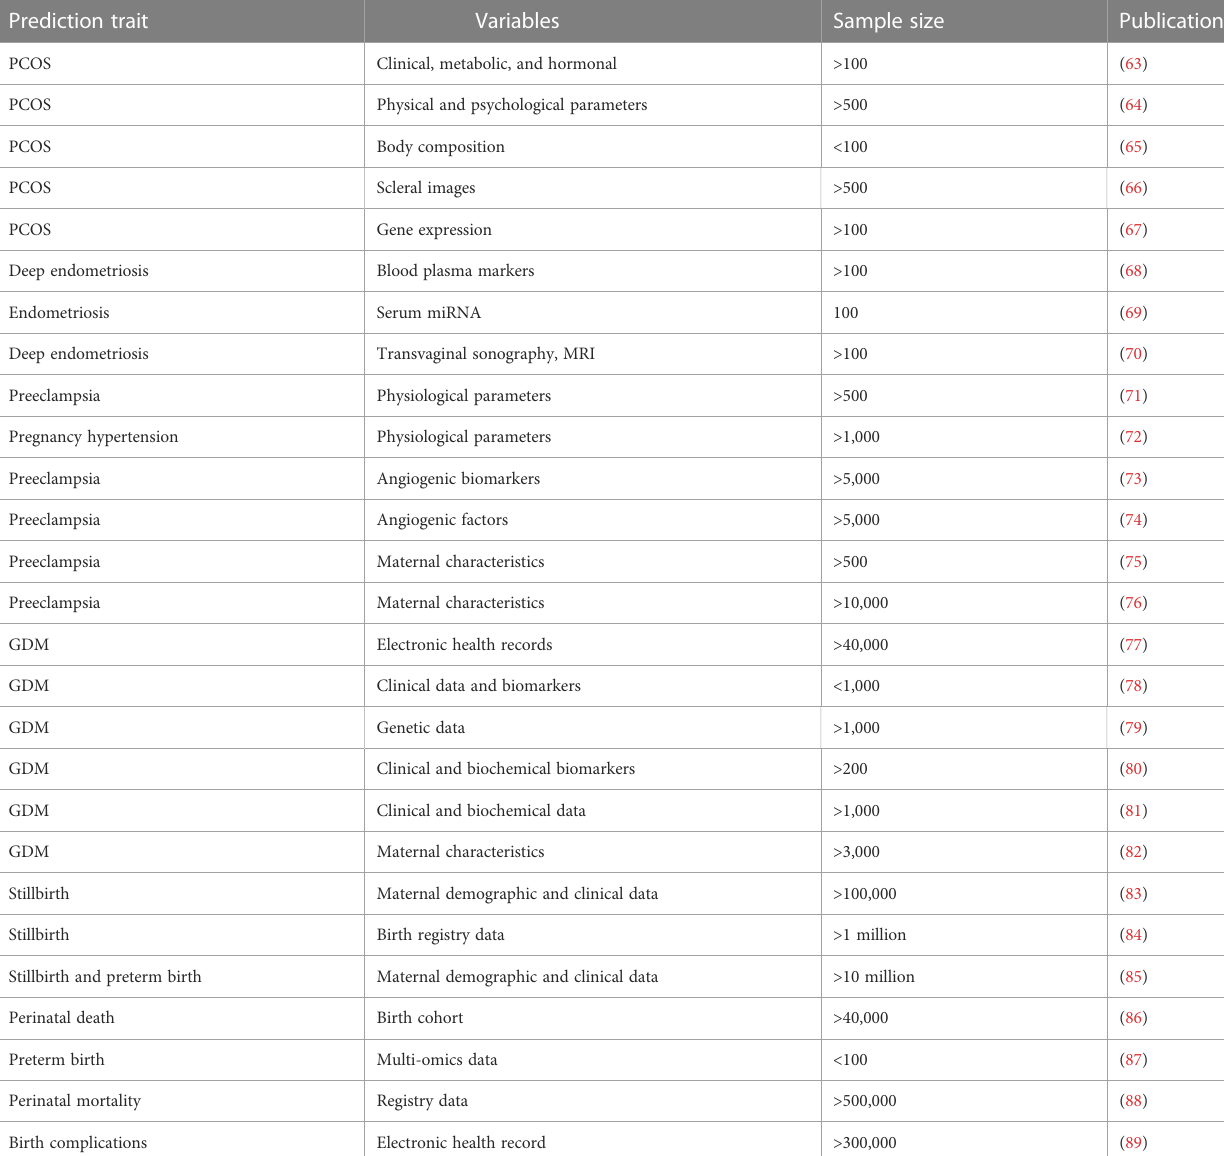
TABLE 2 Overview of predictive models of female reproductive health complications using machine learning approaches. Prediction